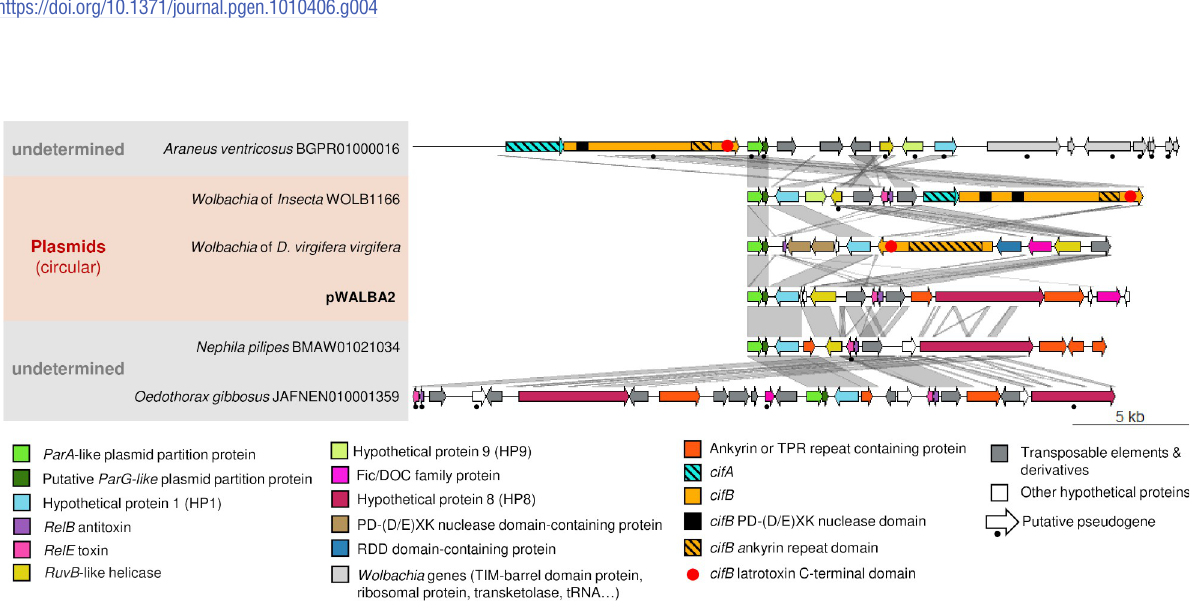
Fig 5. Gene organisation and comparison of other plasmid-like sequences. Similarity is indicated by gene colours (TBLASTN) and by the grey areas between sequences (BLASTN) where darker grey means more similar.